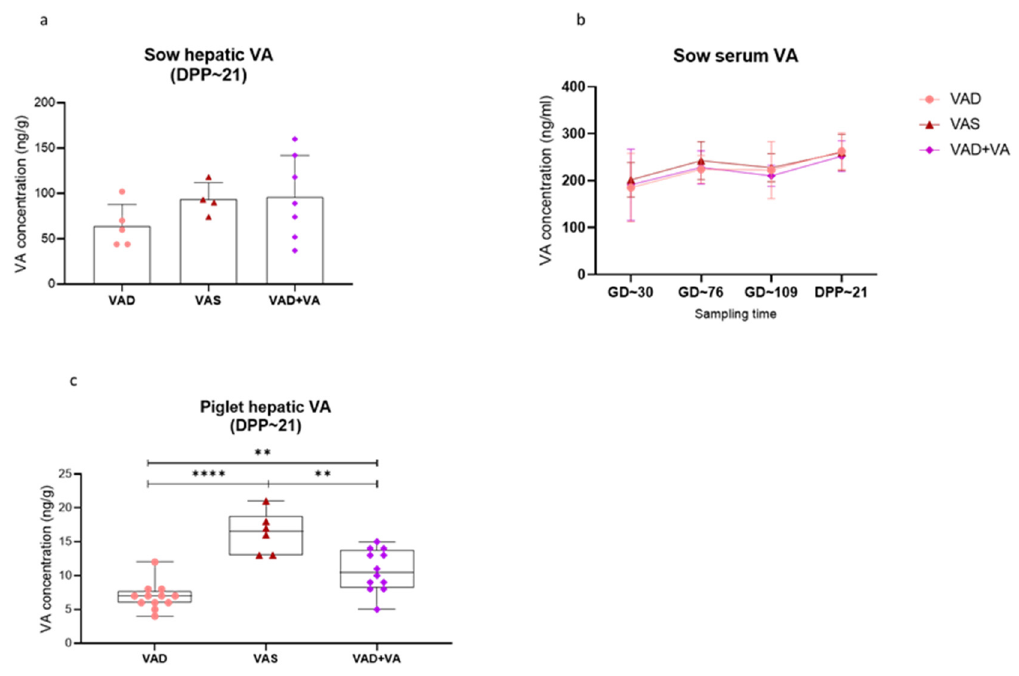
Figure 2. Pregnant sows were placed on different VA regimen diets (VAD, VAS and VAD + VA). Blood was collected for serum processing and livers at euthanasia (Day Post-Partum ~21). VA levels were determined by HPCL at Iowa State University Veterinary Diagnostic Lab (Ames, Iowa). ( a ) Mean hepatic VA concentrations in sows. ( b ) Mean serum VA concentrations in sows. ( c ) Mean hepatic VA concentrations in piglets (** p < 0.01; **** p < 0.0001).